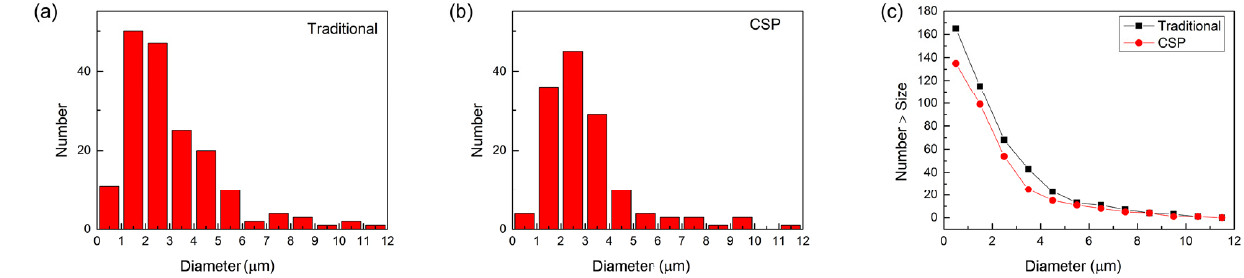
Figure 10. Statistics histograms of TiN inclusions of the ( a ) traditional process, ( b ) CSP process, and ( c ) the cumulative distribution for the Al 2 O 3 /Al inclusions in two processes.